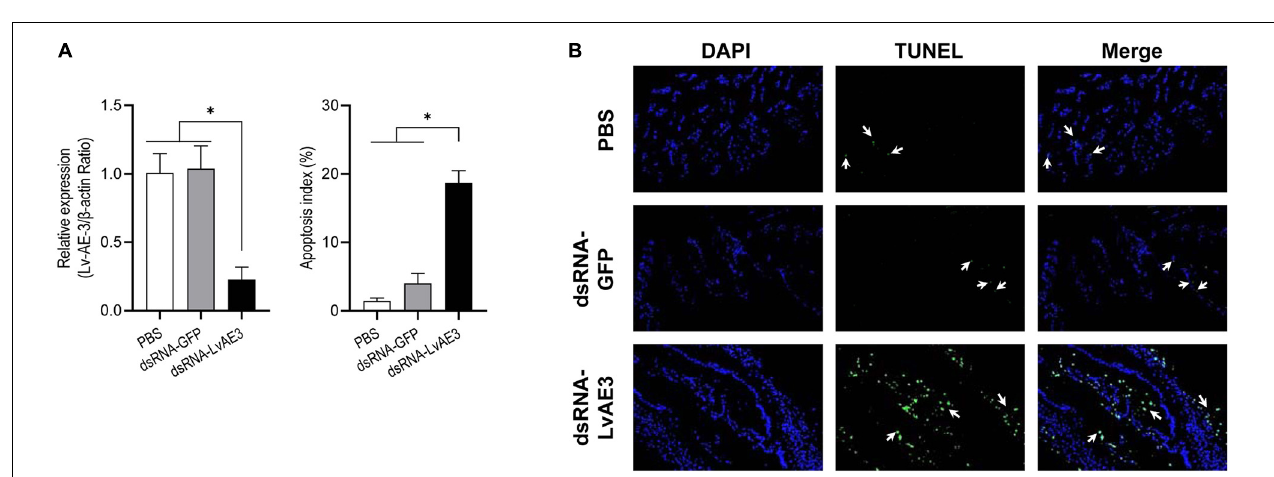
FIGURE 6 | (A) Apoptosis analysis of Litopenaeus vannamei gill. All cell nuclei exhibited blue fluorescence, and the TUNEL-positive cell nuclei exhibited green fluorescence. The apoptotic cells are indicated by the arrows, and the apoptotic indexes were calculated by counting three individuals. (B) Temporal expression of the Lv-AE3 transcripts in the gill after acidity/alkalinity and salinity challenges. The data are presented as the mean ± SE ( n = 3 for apoptosis analysis and n = 5 for mRNA expression), and significant differences were examined with Student’s t -test (* P < 0.05 and ** P < 0.01).